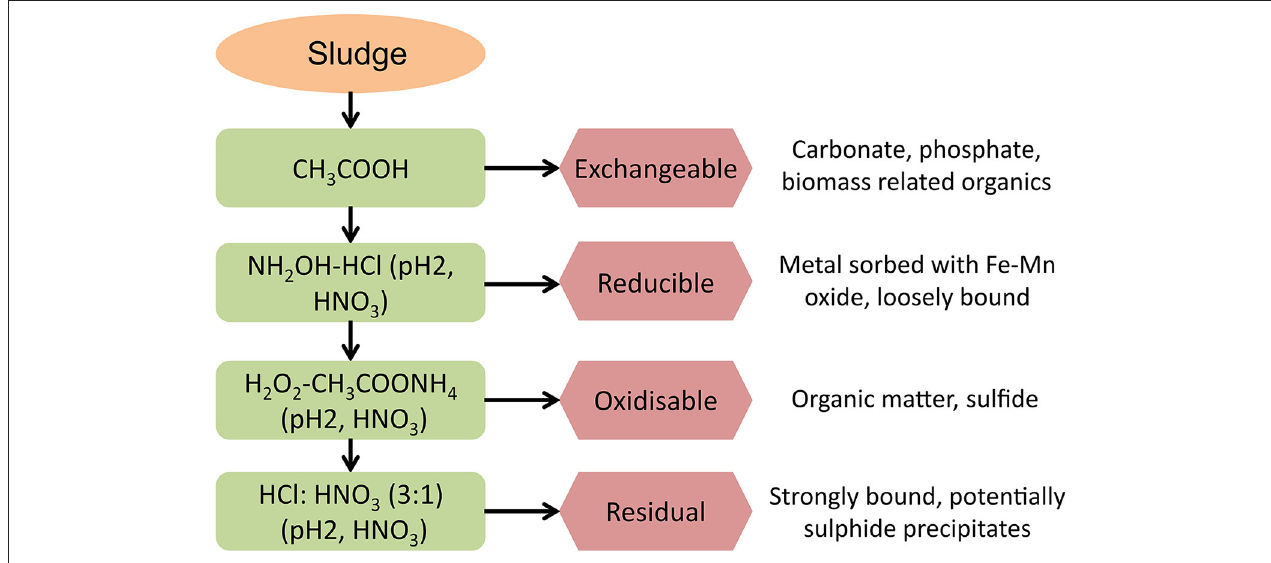
FIGURE 1 | Scheme of the BCR sequential